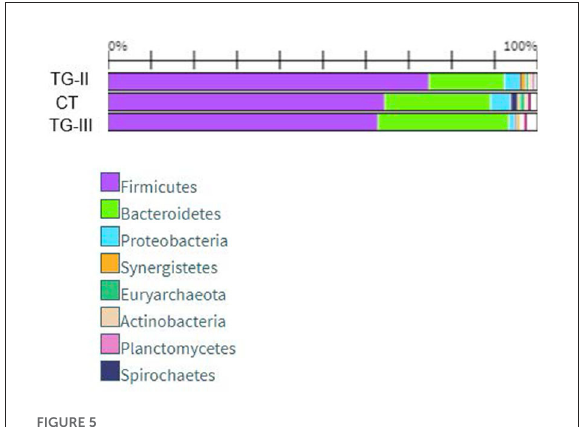
FIGURE5 The data about bacterial genera prevalence in different groups of